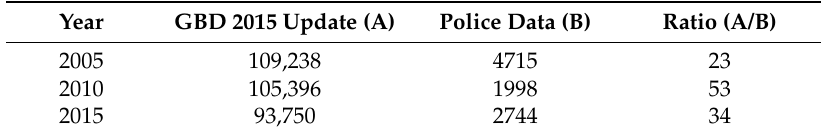
Table 1. Crude deaths from road traffic crashes attributed to alcohol use in China. Year GBD 2015 Update (A) Police Data (B) Ratio (A/B) 109,238